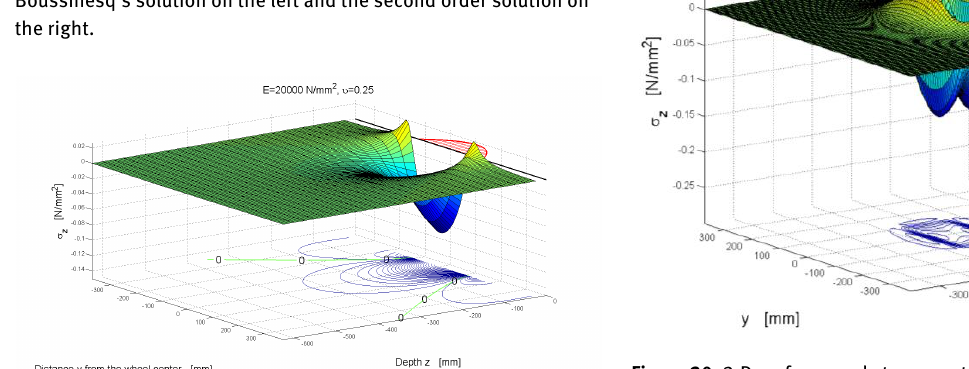
Figure 20: 3-D surfaces and stress contours of σ z near the surface: Boussinesq’s solution on the top and the second order solution on the